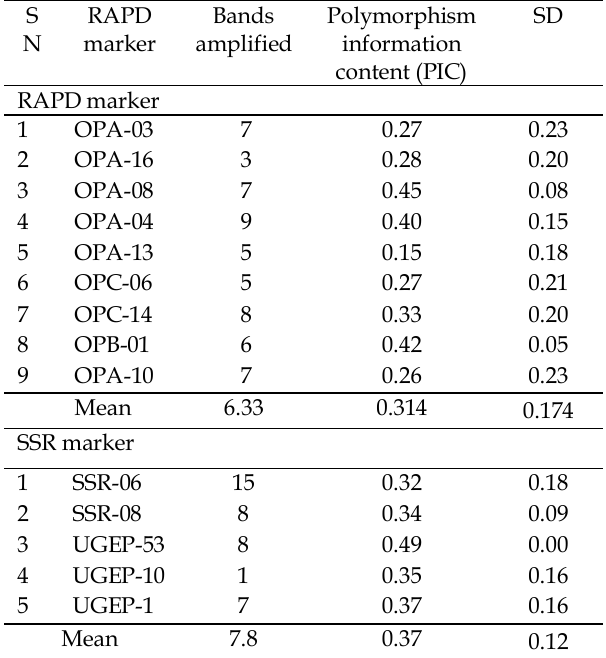
Table 3 . RAPD and SSR primers with number of amplified bands, polymorphism information